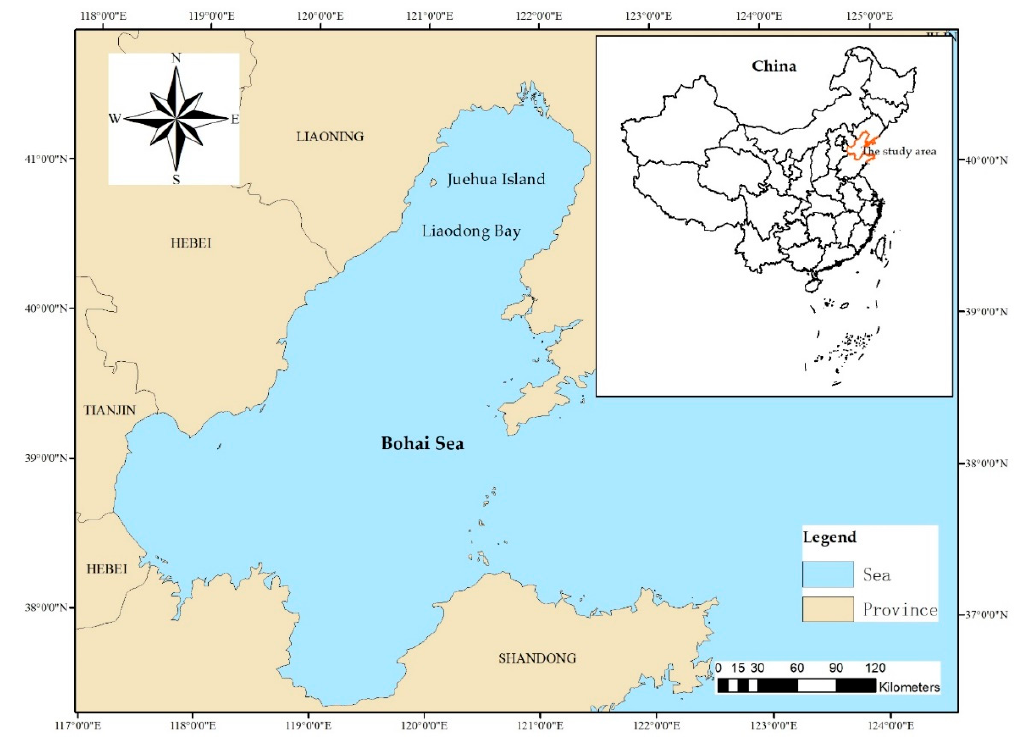
Figure 1. Study site of the Liaodong Bay (China) in Bohai Sea, China.